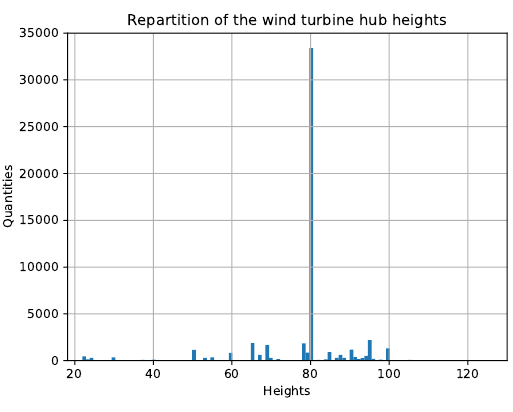
Figure 2. Height histogram of US wind turbines in